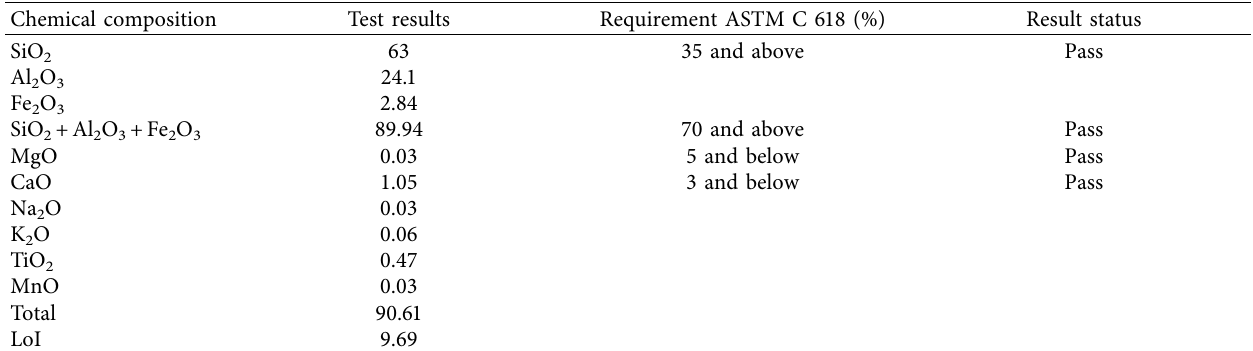
Table 2: Chemical composition of Belessa